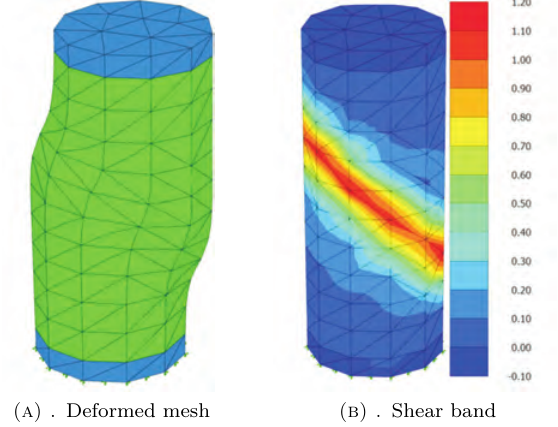
Figure 5. Post peak behaviour.